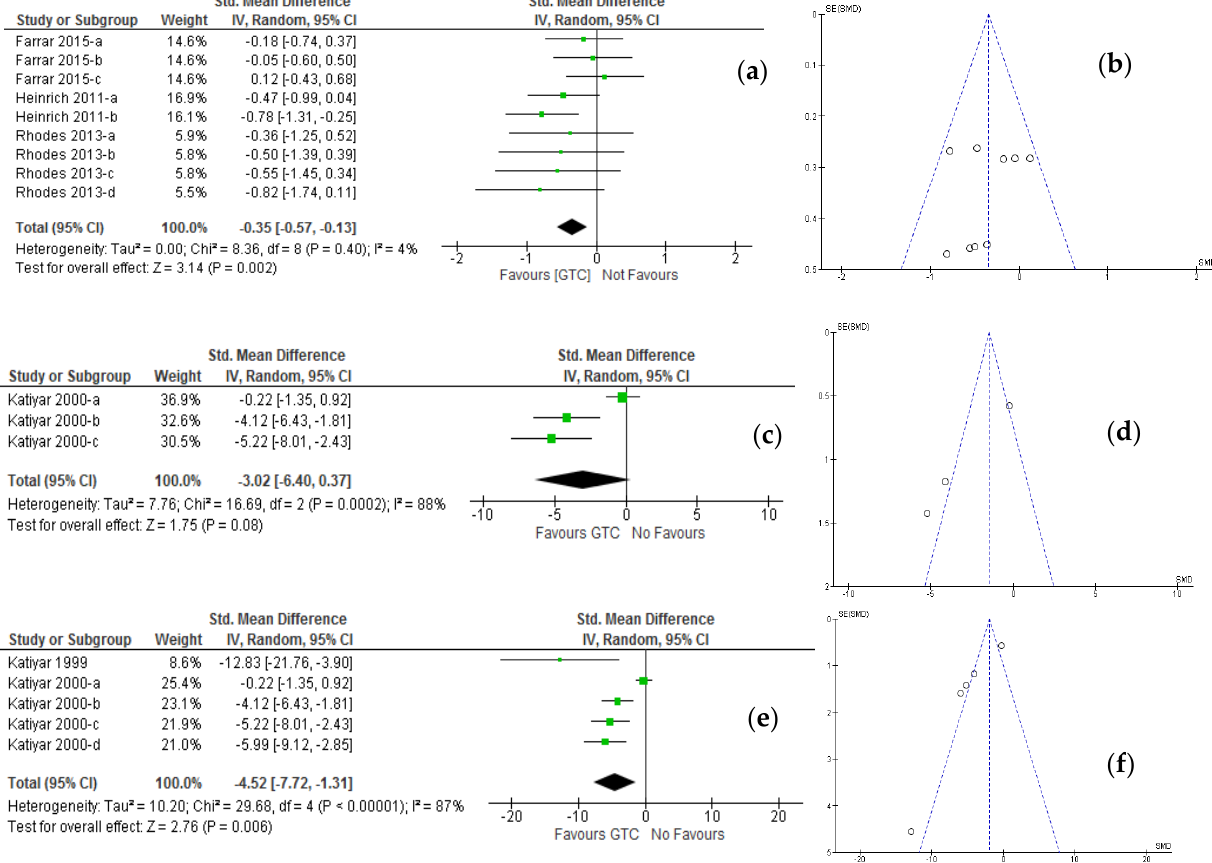
Figure 3. Meta-analysis of the effect of the varying dosages of green tea catechin supplementation on ultraviolet radiation- induced erythema response. ( a ) Forest plot of randomized controlled studies in healthy adults comparing the effect of before (pre-) and after (post-) oral green tea catechin interventions at MED challenge ranges between 1.0–2.5; ( b ) Funnel plot of representative oral green tea catechin supplementation studies ( c ) Forest plot of studies in healthy adults comparing the effect of before (pre-) and after (post-) topically applied green tea catechins at MED challenge ranges between 1.0–2.5; ( d ) Funnel plot of representative topically applied green tea catechin studies. ( e ) Forest plot of studies in healthy adults comparing the effect of before (pre-) and after (post-) topically applied green tea catechins at MED challenge ranges between 0.5–4.0; ( f ) Funnel plot of representative topically applied green tea catechin studies. Keys: Data are presented as mean and SDs, and the effect of studies is presented as weight (percentage) and standardized mean differences (SMDs) at 95% confidence intervals (CIs) using the generic inverse variance (IV) random-effects model. Inter-study heterogeneity was quantified by I 2 statistics with significance p ≤ 0.10. The diamond represents the pooled effect estimated for the overall analysis.